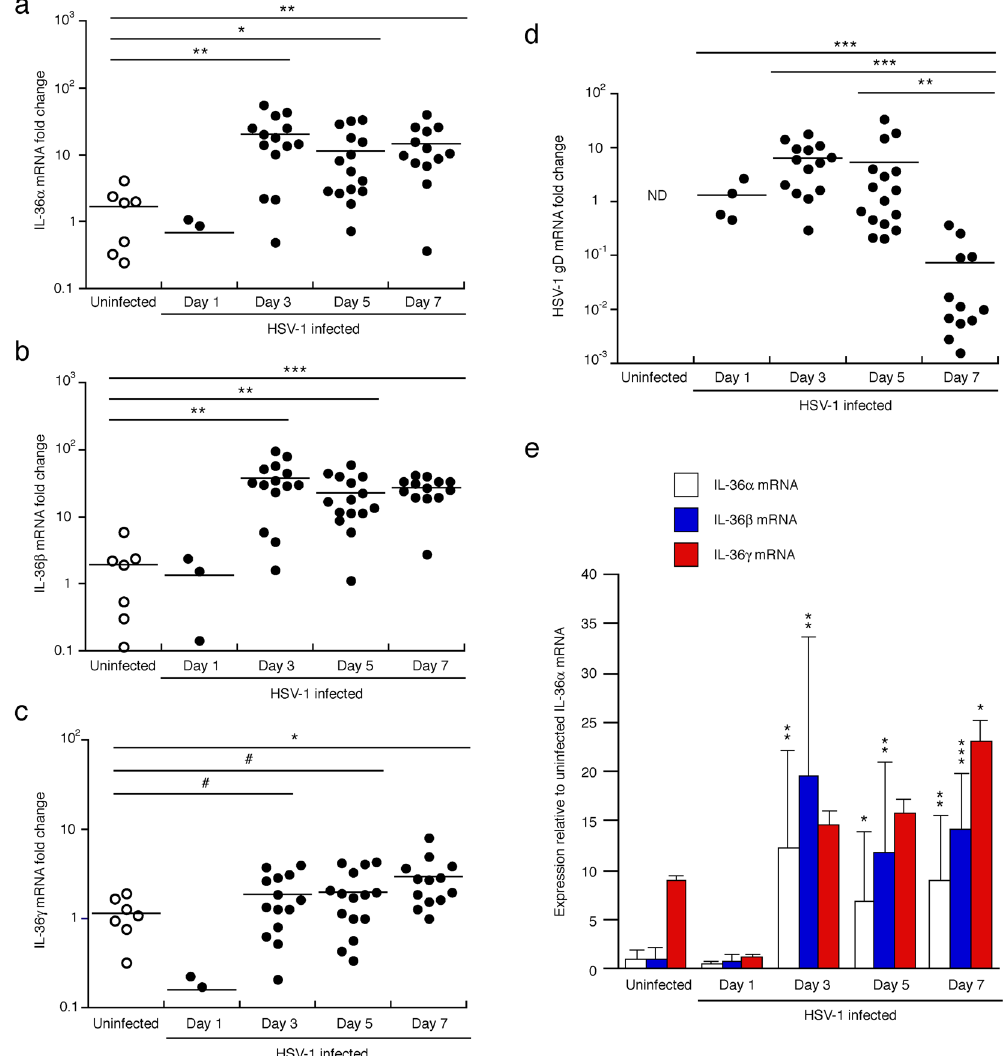
Figure 9. IL-36 mRNA expression is induced in vivo . ( a – d ) C57BL/6 mice were infected with HSV-1 (black symbols) or left uninfected (open symbols). At the indicated time-points primary or mock lesions were collected at the center using 4 mm punch biopsies. IL-36 ( a – c ) and HSV-1 gD ( d ) mRNA levels determined by real-time PCR using GAPDH as the housekeeping gene against which individual mRNA levels were standardized. Fold changes in IL-36 mRNA levels were calculated against uninfected skin. Fold changes in HSV-1 gD mRNA levels were calculated against levels at day 1. Data shown is pooled from three independent experiments. ( e ) IL-36 α (open bars), IL-36 β (blue bars) and IL-36 γ (red bars) mRNA levels were recalculated (data from a – c ) relative to levels of the IL-36 α mRNA in uninfected mice. * p < 0.05; ** p < 0.01; *** p < 0.001; ND, not